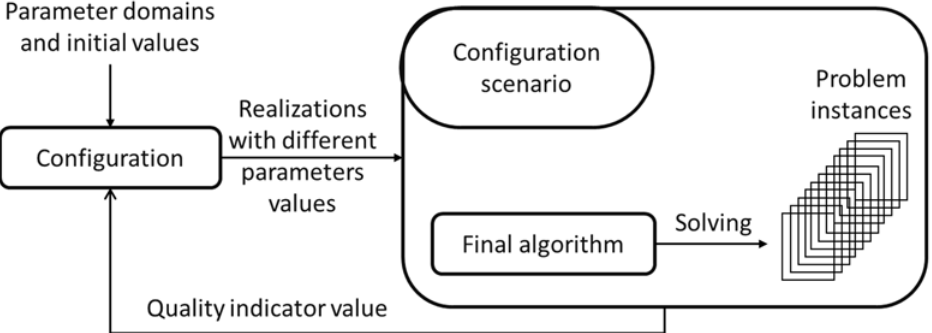
Figure 2. Scheme of the SMAC optimization tool.